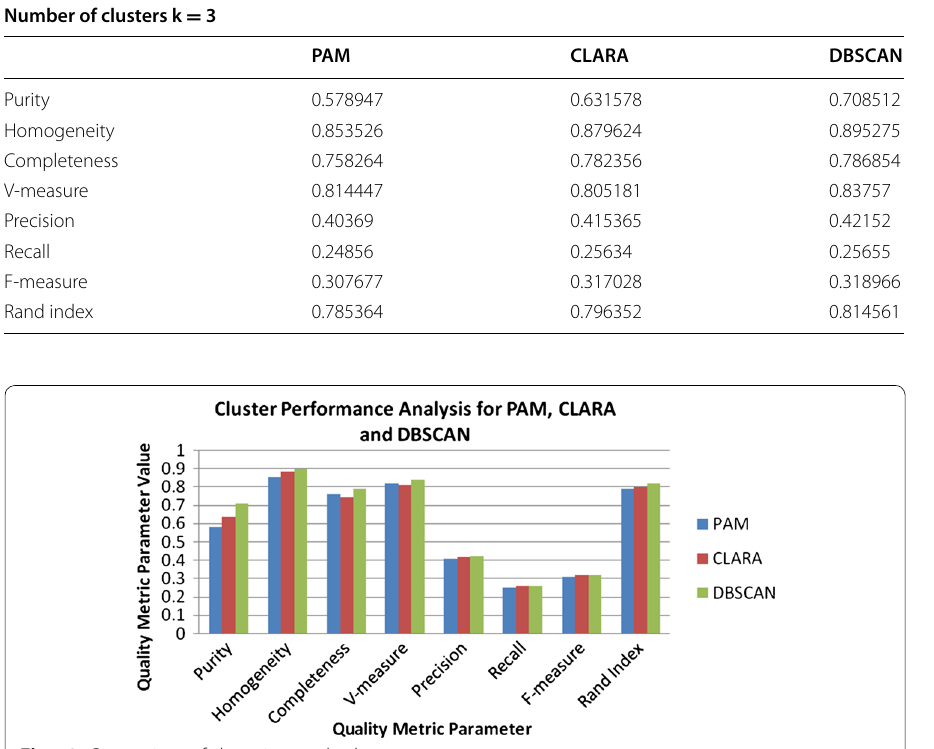
Fig. 13 Comparison of clustering